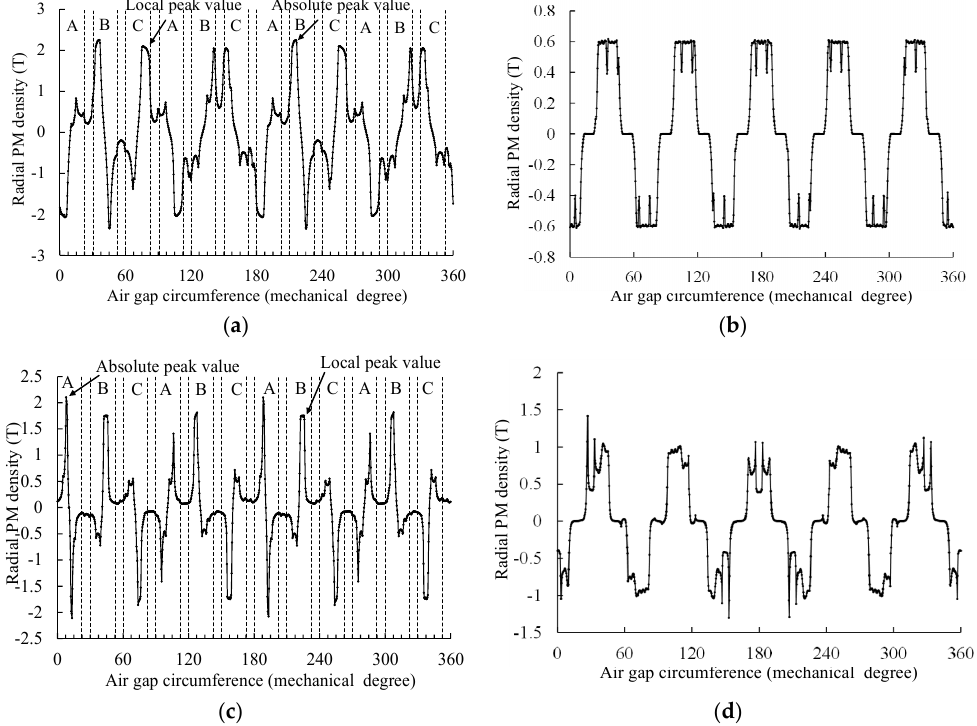
Figure 6. Open ‐ circuit air gap flux density distributions of the two machines due to magnets only. ( a ) Inner FSPM machine of the CADMP ‐ FSPM machine; ( b ) Inner machine of the DMP machine; ( c ) Outer FSPM machine of the CADMP ‐ FSPM machine; ( d ) Outer machine of the DMP machine. The corresponding phase electro ‐ motive force (EMF) per turn of the CADMP ‐ FSPM machine